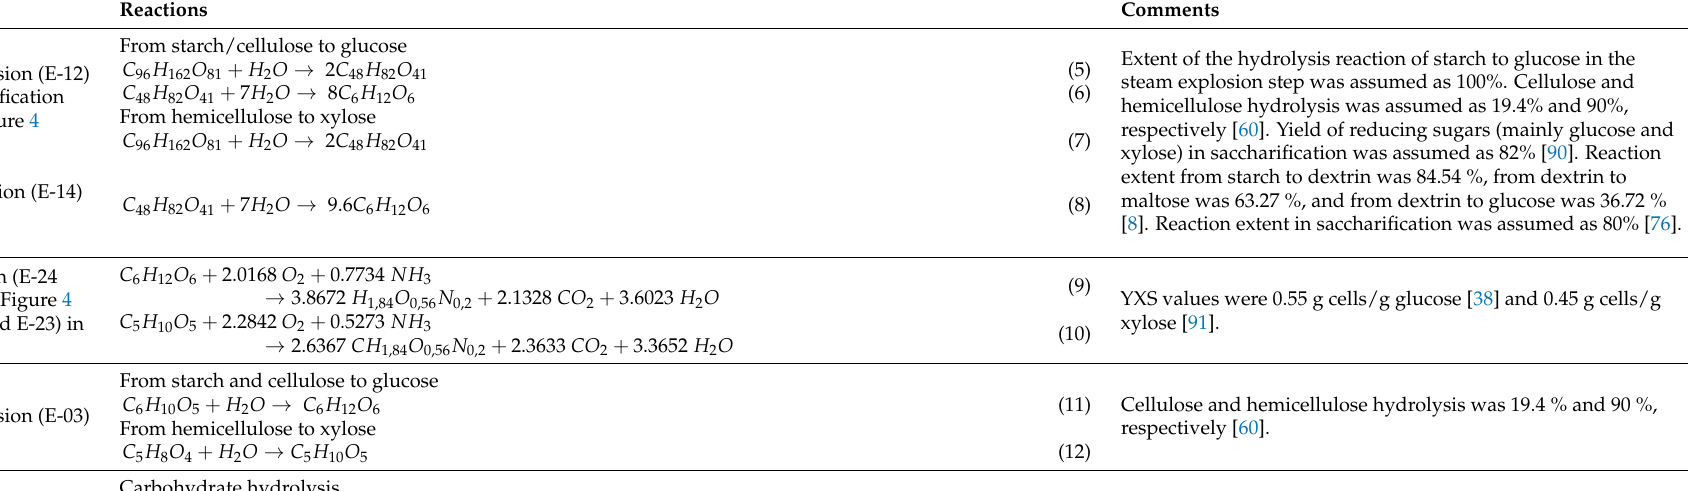
Table 6. Reactions involved during the simulation of the process flowsheets for SCP and biomethane production. Process From starch/cellulose to glucose